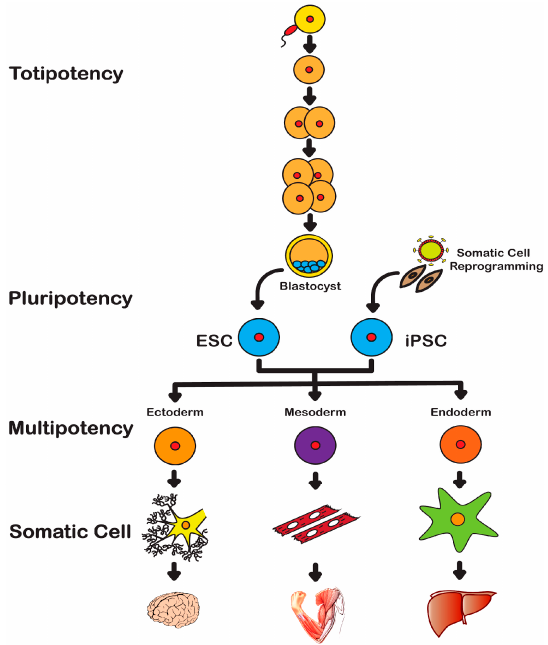
Figure 1. Totipotency: After fertilization, Embryonic Stem Cells (ESCs) maintain the ability to form all three germ layers as well as extra-embryonic tissues or placental cells and are termed as totipotent. Pluripotency: These more specialized cells of the blastocyst stage maintain the ability to self-renew and differentiate into the three germ layers and down many lineages but do not form extra-embryonic tissues or placental cells. Reprogrammed somatic cells, iPSCs, also demonstrate the ability to self-renew and differentiate into all three germ layers in vivo and in vitro . Thus, iPSCs are also considered to be pluripotent stem cells. Multipotency: Adult or somatic stem cells are undifferentiated cells found in postnatal tissues. These specialized cells are considered to be multipotent; with very limited ability to self-renew and are committed to lineage specific differentiation.